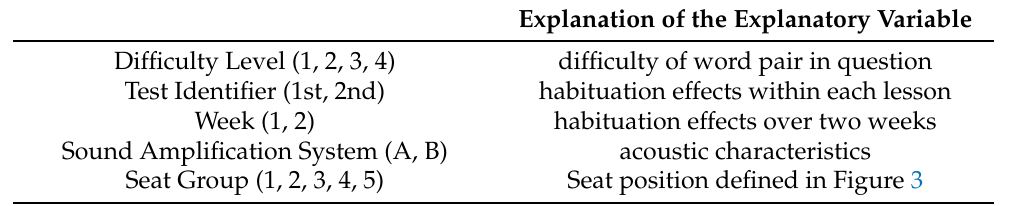
Table 3. Explanatory variables assumed in the